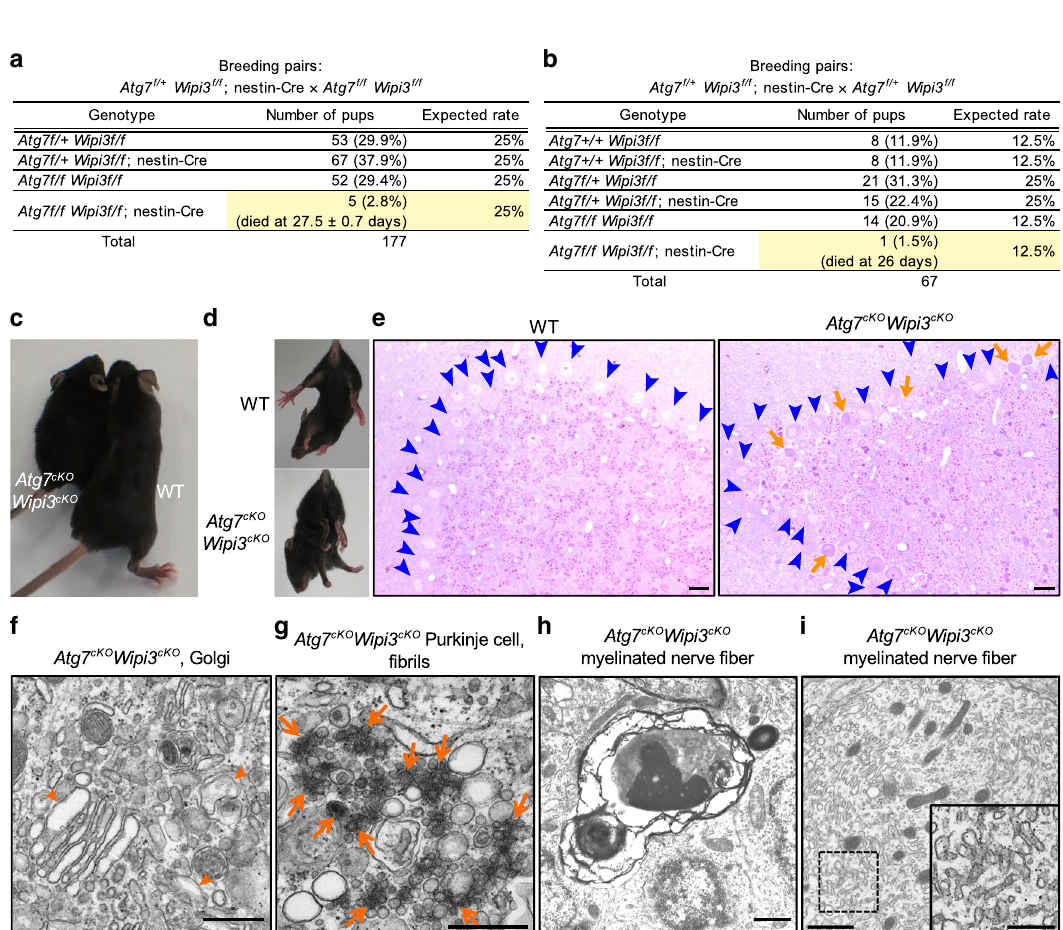
Fig. 9 Suppression of the neurological defects of Wipi3 cKO mice by Dram1. a The indicated genes were transfected with a lentivirus containing IRES-GFP into the cerebella of Wipi3 cKO mice at 5-weeks of age (Supplementary Fig. 25). At 10-weeks, the expression of GFP and other molecules were con fi rmed by GFP fl uorescence and immunostaining using an anti-Flag antibody. Bars = 200 µ m. b , c Recovery of abnormal motor performance of Wipi3 cKO mice by the expression of Dram1 at 10 weeks. Both the footprint assay ( b ) and rotarod test ( c ) demonstrated the suppression of the motor de fi cits of Wipi3 cKO mice by Dram1. Data are shown as the mean ± SD ( n = 3 experiments). d Semi-thin sections of the cerebellum from Wipi3 cKO mice transfected with an empty vector or a vector for Dram1 were stained with toluidine blue. Orange arrows and blue arrowheads indicate dead and live Purkinje cells, respectively. Bars = 20 µ m. Dram1 rescued Purkinje cell loss. e Cryosections of the cerebellum from the indicated mice were stained with Prussian blue. Bars = 20 µ m. f , g Morphology of the Golgi ( f ) and myelinated nerve fi bers ( g ) from the cerebella of the indicated mice. Swollen Golgi and damaged myelinated fi bers were rescued by Dram1. Bars = 0.5 µ m ( f ) and 5 µ m ( g ). h Table summarizing the EM observations. In ( c ), comparisons were performed using one-way ANOVA followed by the Tukey post hoc test. * p < 0.05 and ** p < 0.01 vs the value of Vector (Dram1: p = 0.0135, Wipi3: p = 0.0017). Source data are provided as a Source Data fi le.